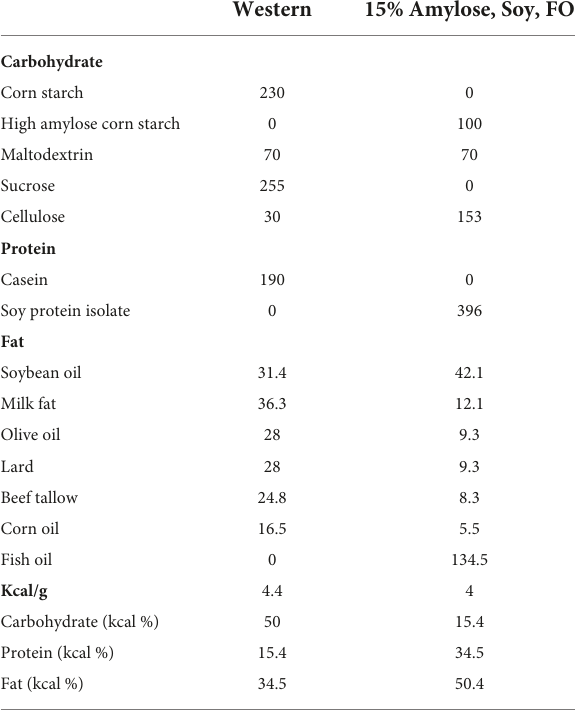
TABLE 1 Diet formulation expressed as g/kg of